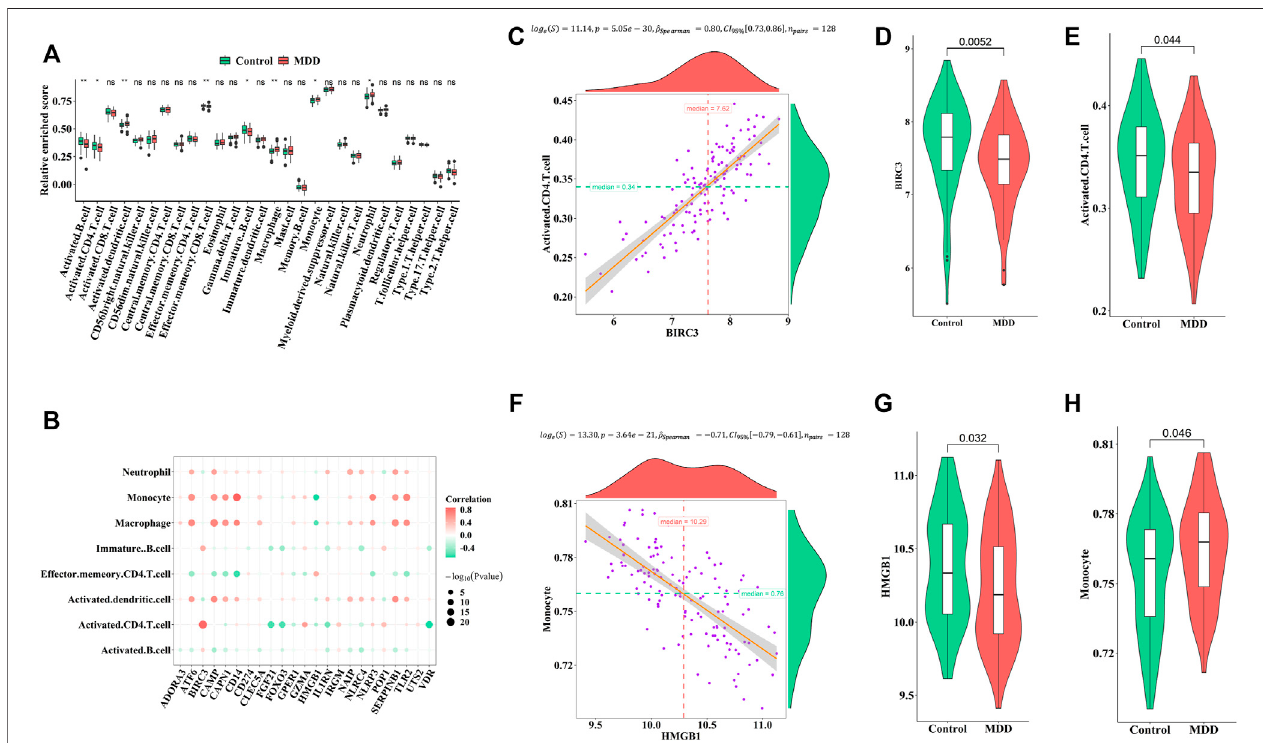
FIGURE 5 | Correlation between pyroptosis-related genes and immune in fi ltrating cells (A) . Differences in the abundance of immune in fi ltrating cells between healthycontroland MDDsamples (B) . Correlation betweenpyroptosis-related genesand immune in fi ltrating cells (C – E) .The mostpositivecorrelationbetween immune in fi ltratingandpyroptosis-relatedgenes (F – H) .Themostnegativecorrelationbetweenimmunein fi ltratingandpyroptosis-relatedgenes.Adjusted p -valueswereshowed as: ns, not signi fi cant; * p < 0.05; ** p <